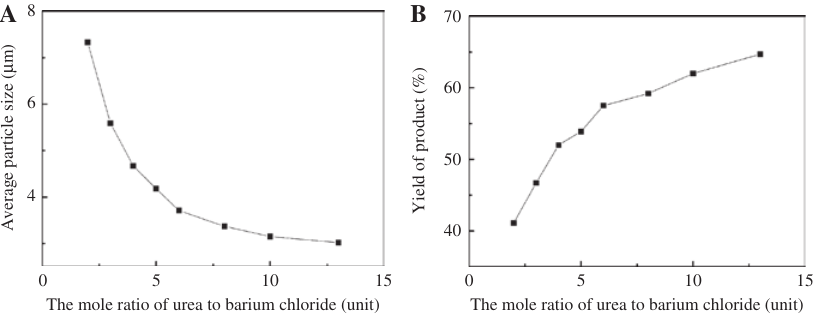
) CO concentration on average particle size (A) and yield of product (B), respectively, in the homogeneous Figure 3: Effect of (NH 2 2 precipitation.